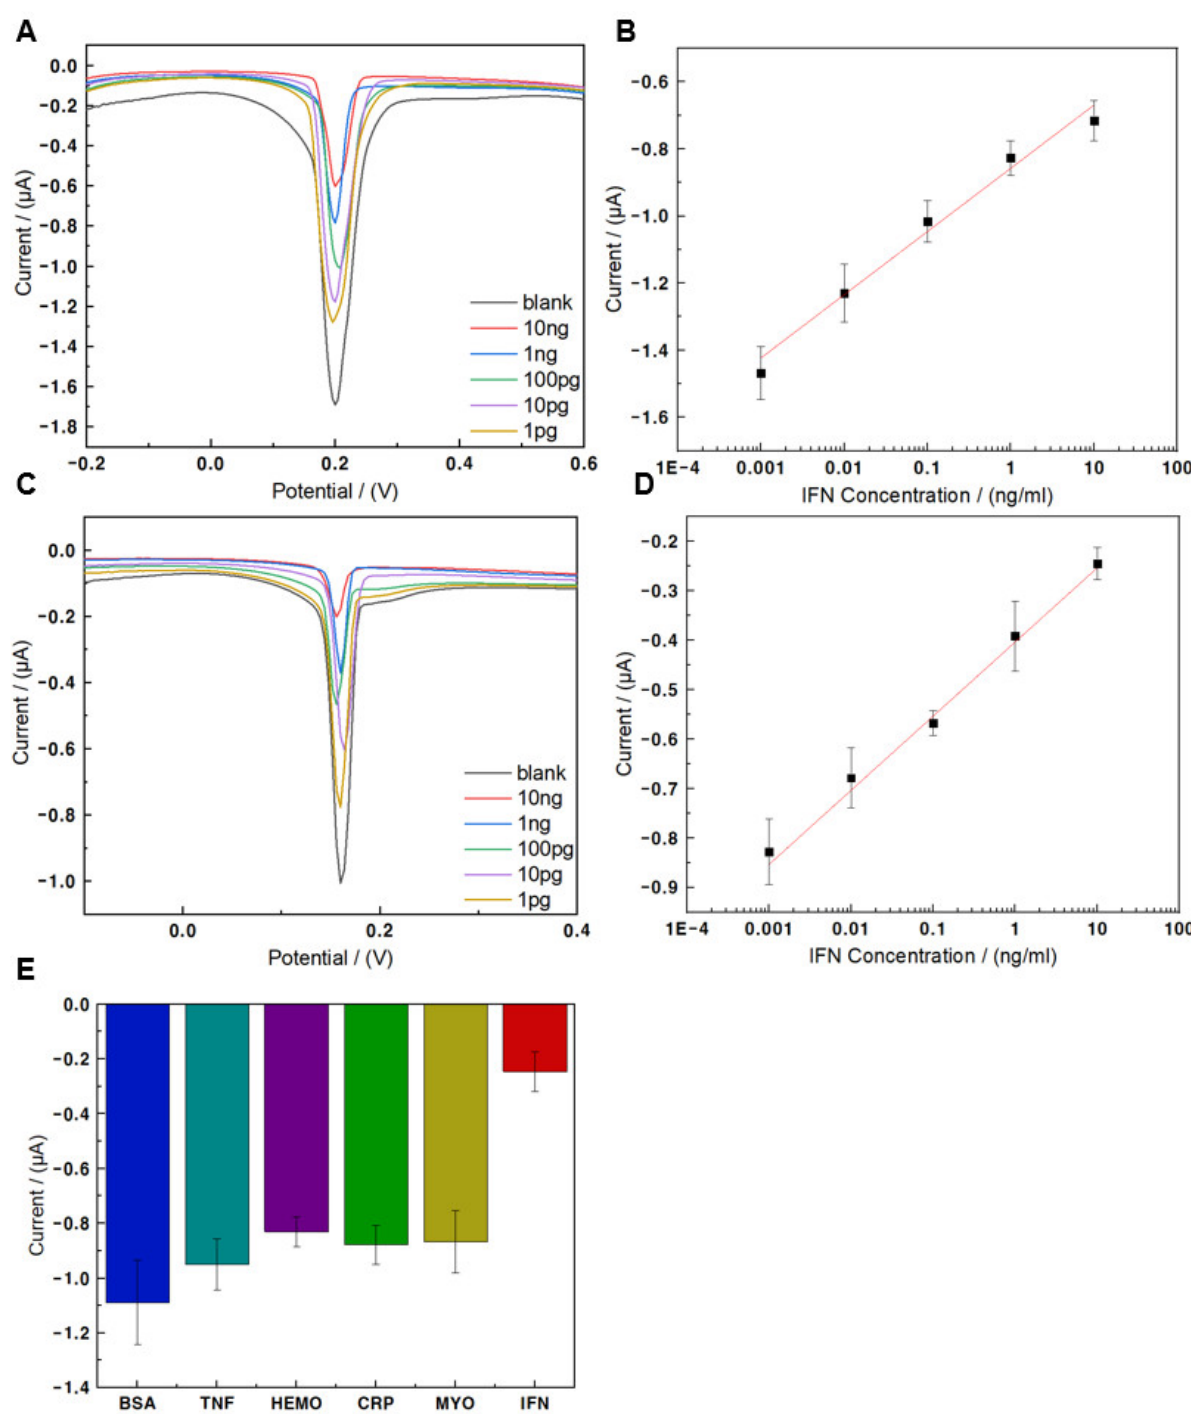
Figure 5. ( A ) Square wave voltammetry at different concentrations of interferon gamma (IFN-γ) diluted with phosphate- buffered saline (PBS) in 10 mM HEPES (pH 7.03). ( B ) Calibration curve of different concentrations of IFN-γ in PBS, linear range from 10 ng/mL to 1 pg/mL. ( C ) Square wave voltammetry at different concentrations of IFN-γ diluted with 10% human serum in 10 mM HEPES (pH 7.03). ( D ) Calibration curve of different concentrations of IFN-γ in 10% human serum, linear range from 10 ng/mL to 1 pg/mL. ( E ) Current of several proteins based on selectivity.